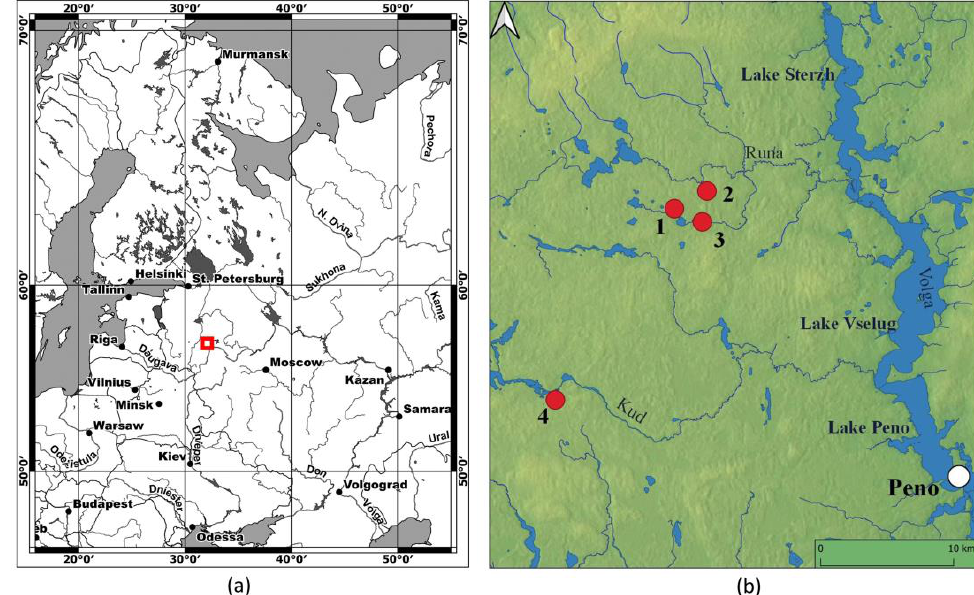
Figure 1. ( a ) Location of the study area and ( b ) local areas (sites): 1 — Krasnyi Bor, 2 — Runa-Zabo- rovka, 3 — Zaborovka-Likhusha, 4 — Voroshilovo.